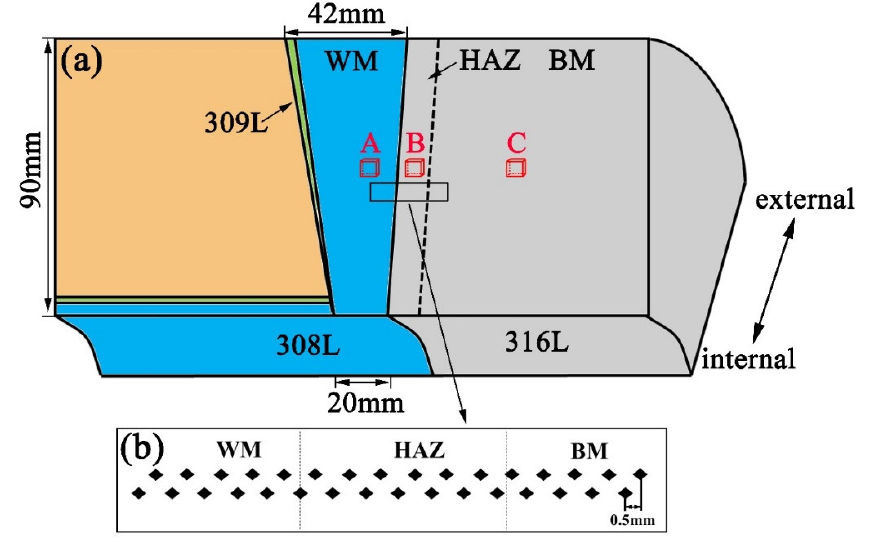
Figure 2. The specimens for electrochemical tests were grinded and then polished. The specimens